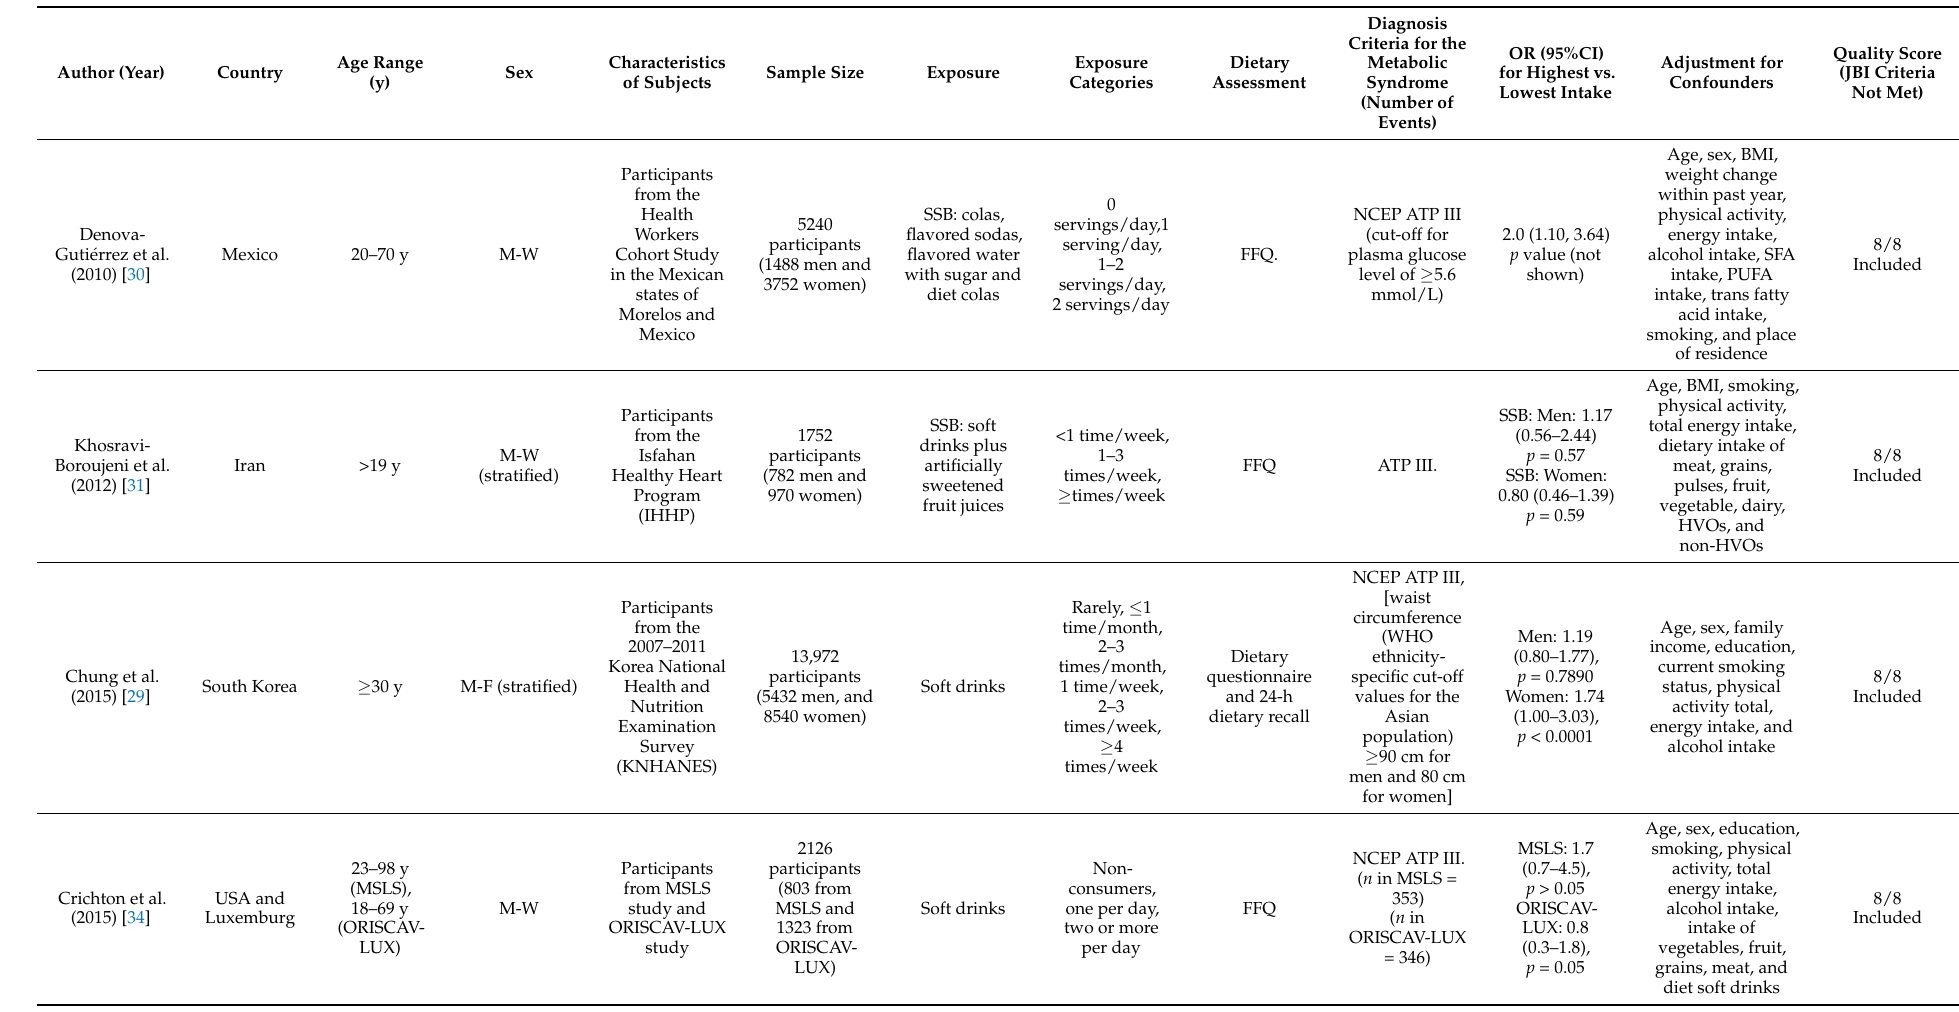
Table 2. Characteristics of the cross-sectional studies sorted by inclusion status and chronological year of